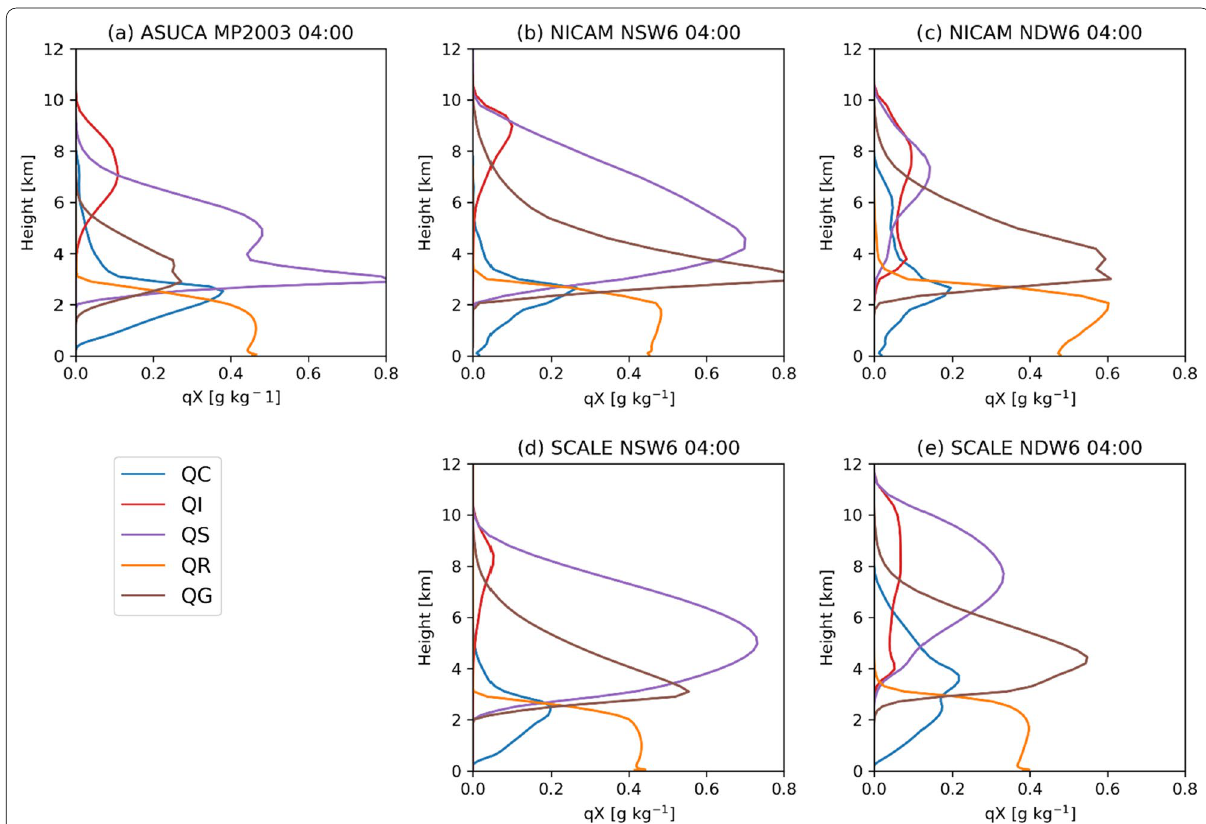
Fig. 13 Domain-averaged vertical distribution of hydrometeors at 4:00 UTC on April 18, 2020, for the region shown by the green area in Fig. 3. a ASUCA, b NICAM-NSW6, c NICAM-NDW6, d SCALE-NSW6, and e SCALE-NDW6. The vertical axis is altitude [km], and the horizontal axis is the mass concentration [g kg − 1 ]. Hydrometeors include cloud water (blue), rain (orange), cloud ice (red), snow (purple), and graupel